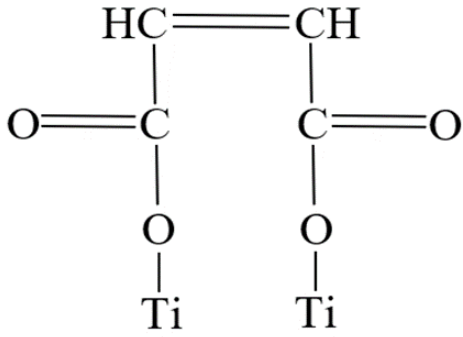
Figure 2. Proposed structure arrangement of 2Ti-MAH.